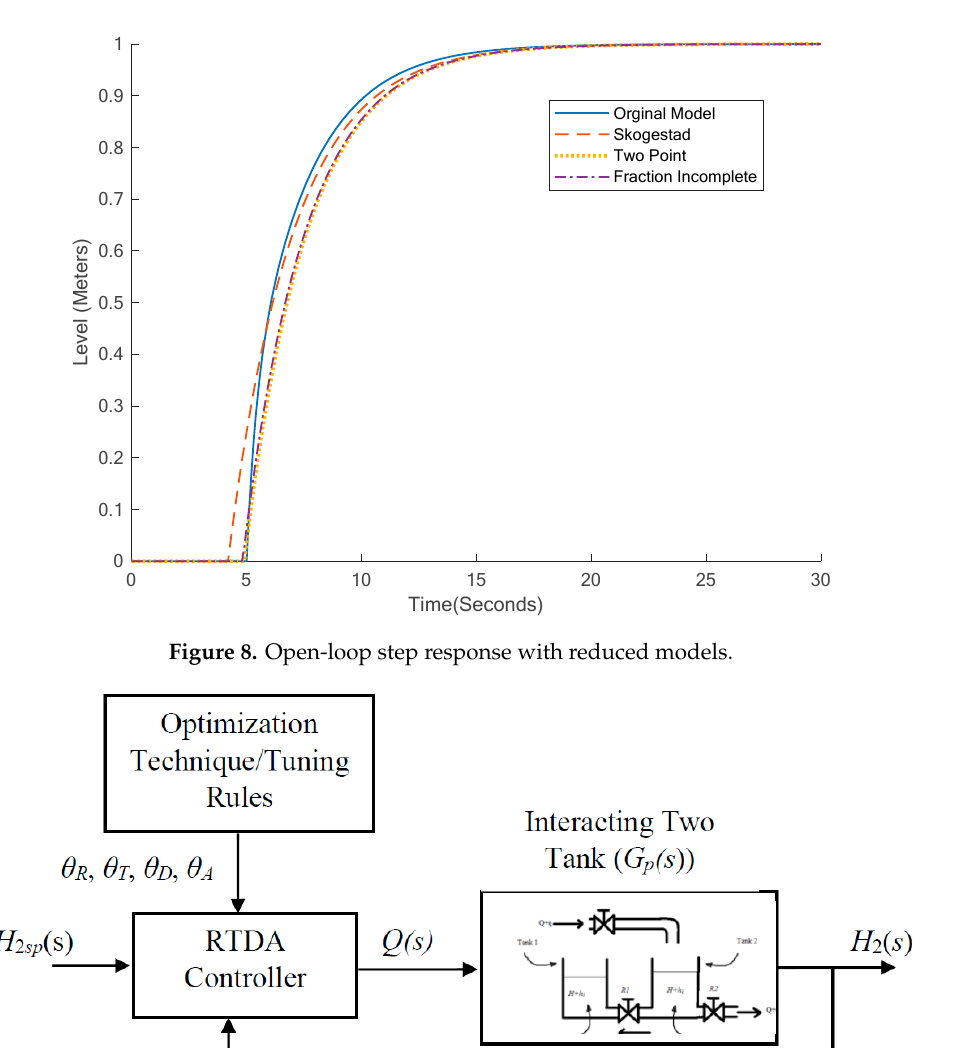
Table 4. Example 1: Tuning parameters with two tuning methods [4].